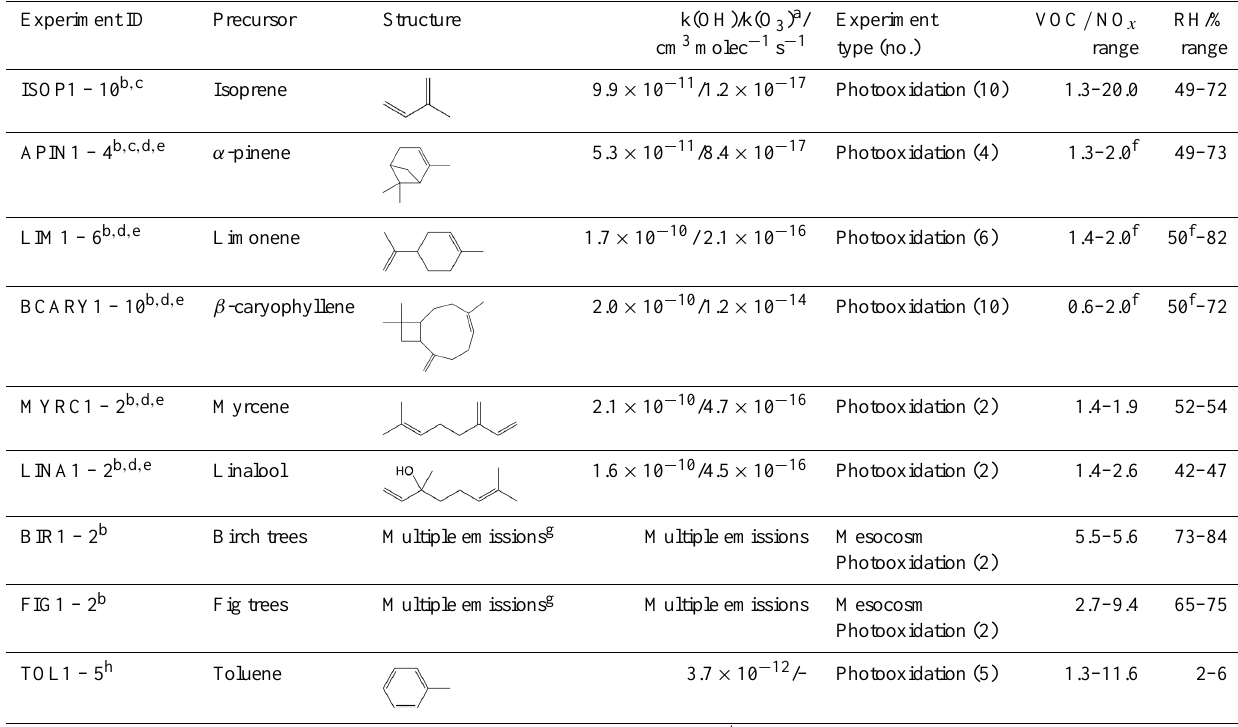
Table 1: Summary of experiments Table 1. Summary of experiments conducted.